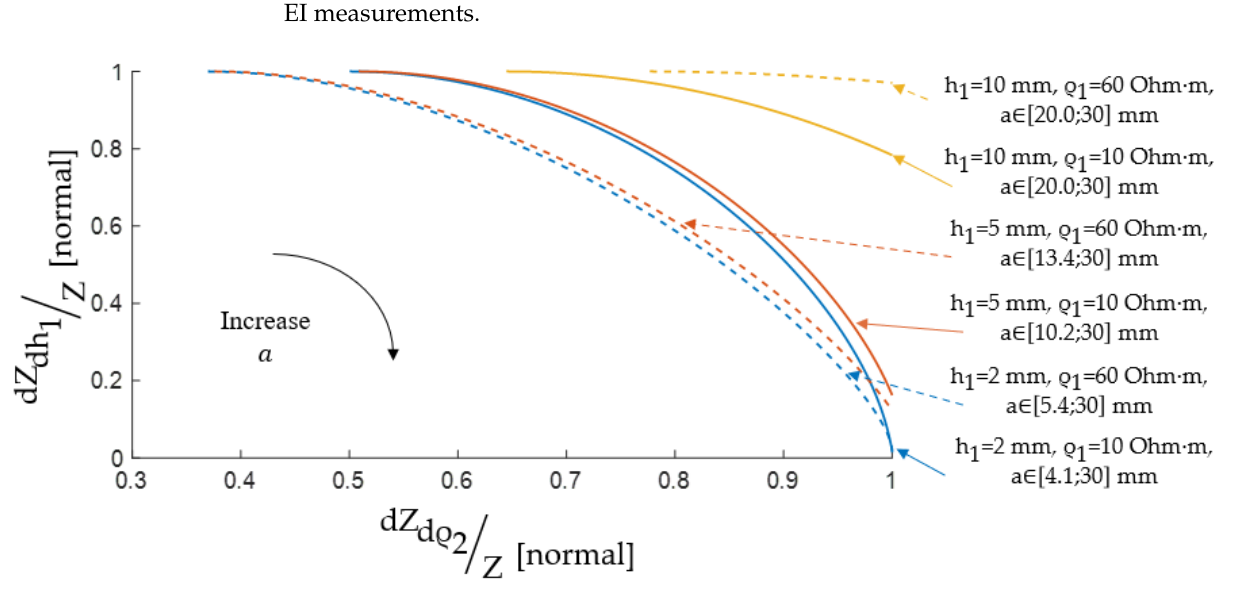
Figure 14. The Pareto optimal solutions are set for the interelectrode distance choice.